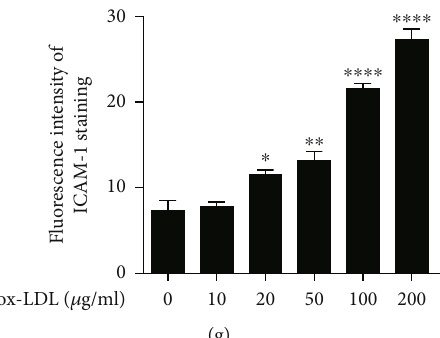
Figure 1: HUVEC injury caused by ox-LDL stimulation at di ff erent concentrations HUVECs were stimulated with 0, 10, 20, 50, 100, and 200 μ g/mL ox-LDL for 24 h. Changes in (a) cell morphology in di ff erent groups. (b) Cell survival rate in di ff erent groups by CCK-8 assay. Scale bar = 200 μ m. (c) Changes in MDA levels. (d, e) DHE immuno fl uorescence image and densitometry analysis of immuno fl uorescent intensity of DHE. Scale bar = 50 μ m. (f, g) ICAM1 immuno fl uorescence image and densitometry analysis of immuno fl uorescent intensity of ICAM1. Scale bar = 50 μ m. DHE: dihydroethidium; HUVECs: human umbilical vein endothelial cells; ox-LDL: oxidized low-density lipoprotein; MDA: malondialdehyde. The statistical analyses were done using GraphPad Prism V-7.0 software. Data are expressed as the mean ± standard deviation ( n = 3 ). One-way ANOVA was used in statistical analyses ( n = 3 /group). ∗ P < 0 : 05 , ∗∗ P < 0 : 01 , ∗∗∗ P < 0 : 001 , and ∗∗∗∗ P < 0 : 0001 versus the